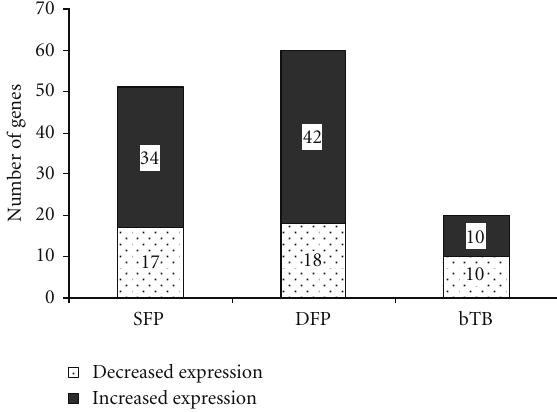
Figure 2: Numbers of gene features identified from analysis of microarray data that were di ff erentially expressed ( P ≤ 0 . 01) among single antemortem test-false positive (SFP), double antemortem test-false positive (DFP), and bTB-infected (bTB) groups of cattle. The numbers of genes common to or unique for the groups of cattle are shown in a Venn